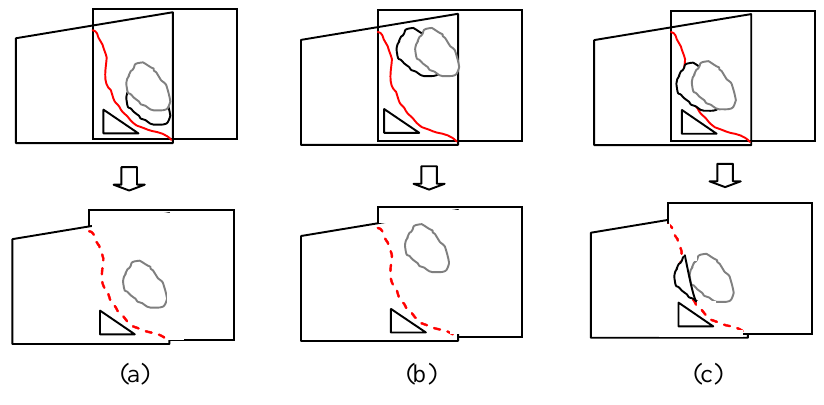
Figure 5. ( a ) The original aligned frame with a stitching line; ( b ) newly aligned frame with changes not cross the line; ( c ) frame with changes cross the